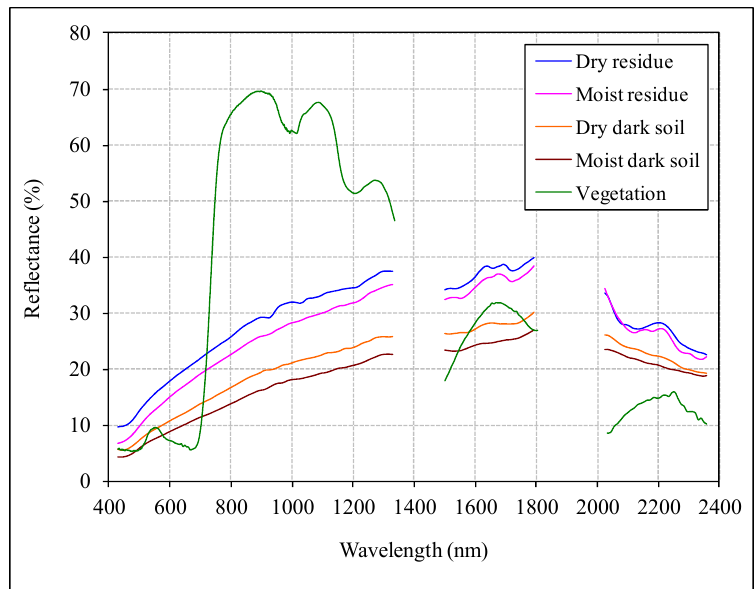
Figure 4. Endmember spectra convolved with the band centers of the Hyperion EO-1 sensor and used for Constrained Linear Spectral Mixture Analysis (CLMSA).